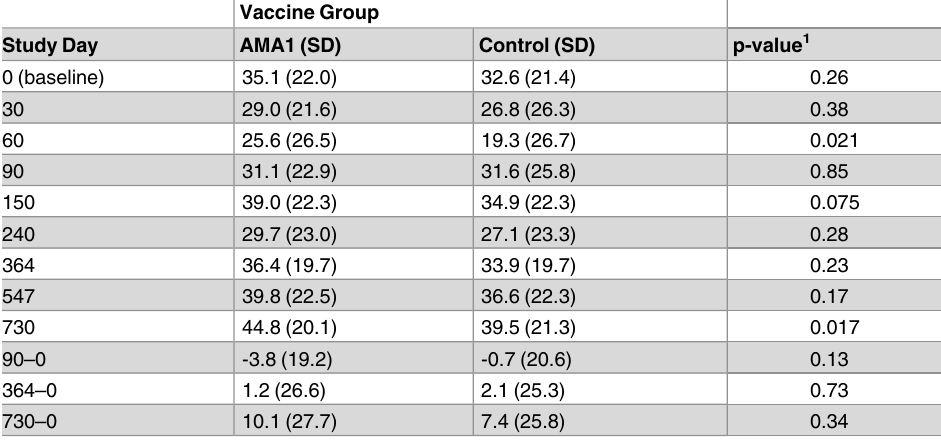
Table 3. Mean FVO growth inhibition assay result, and change from baseline to 30 days after last vac- cination and one and two years after enrollment, with standard deviation (SD), by vaccine group. Vaccine